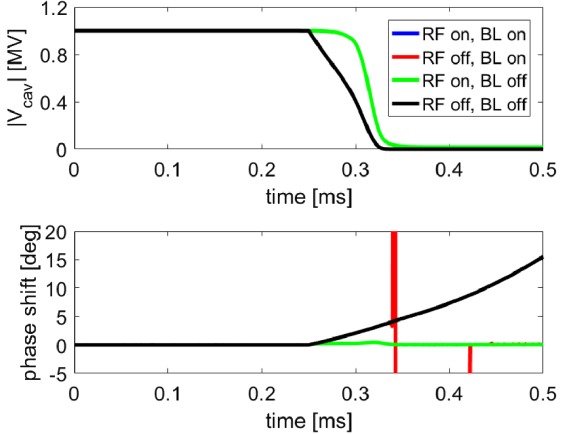
FIG. 8. Plots of cavity voltage amplitude (top) and phase (bottom) for a KEKB-like cavity at 2K during a quench, comparing the effects of the rf system and beam